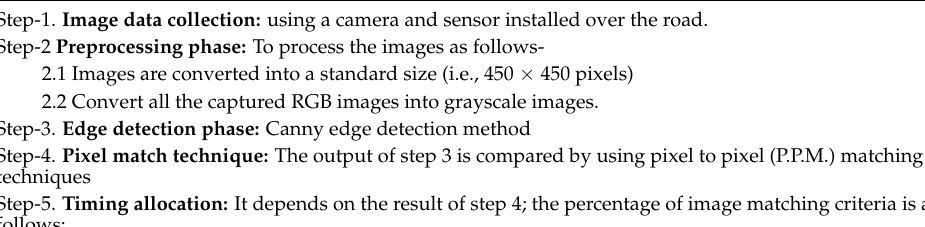
Algorithm 1: Image processing in the intelligent transport system